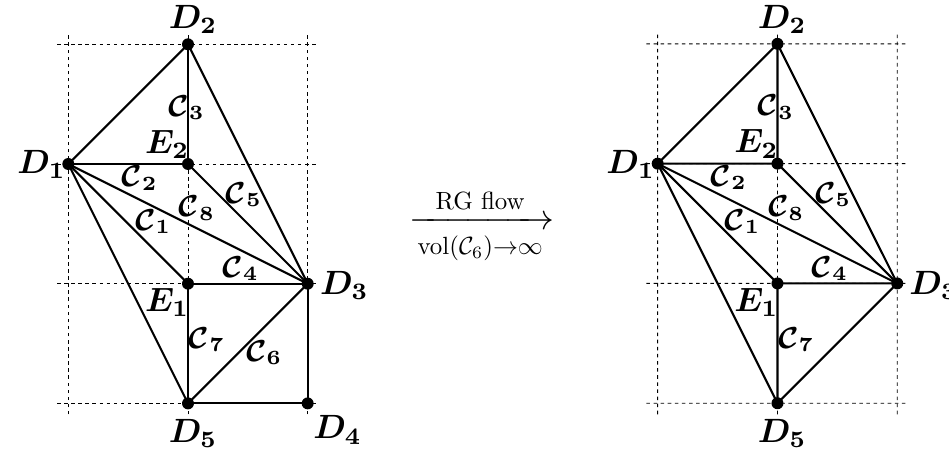
Figure 27 . Decoupling the divisor D 4 leads to a crepant resolution of the E 12 ; 1 singularity. For example, one such transformation is ( T S ) 2 T (cid:0) 1 S (cid:0) 1 , which leads precisely to